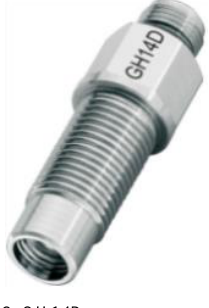
Fig. 2. GH14D pressure sensor